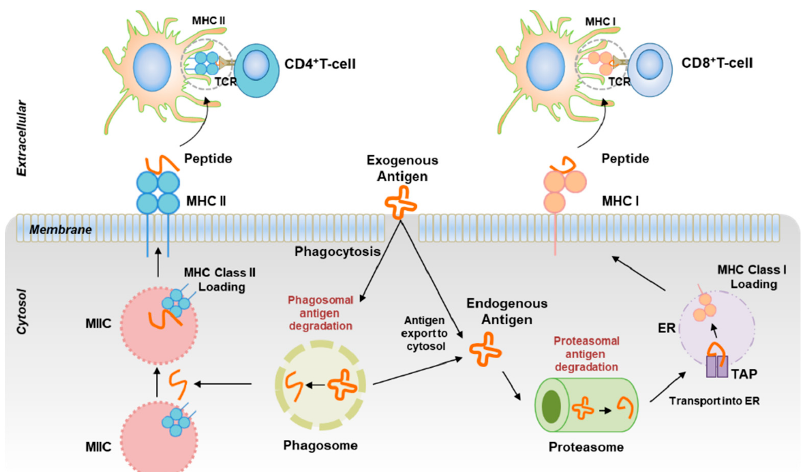
Figure 1. Schematic diagram for the cross-presentation machinery of DCs. DCs take up extracellular antigen, process it to antigenic peptides, and present these peptides not only with MHC II through the MIIC to CD4 + T cells ( left ), but also with MHC I through proteasome and the TAP / ER pathway to CD8 + T cells ( right